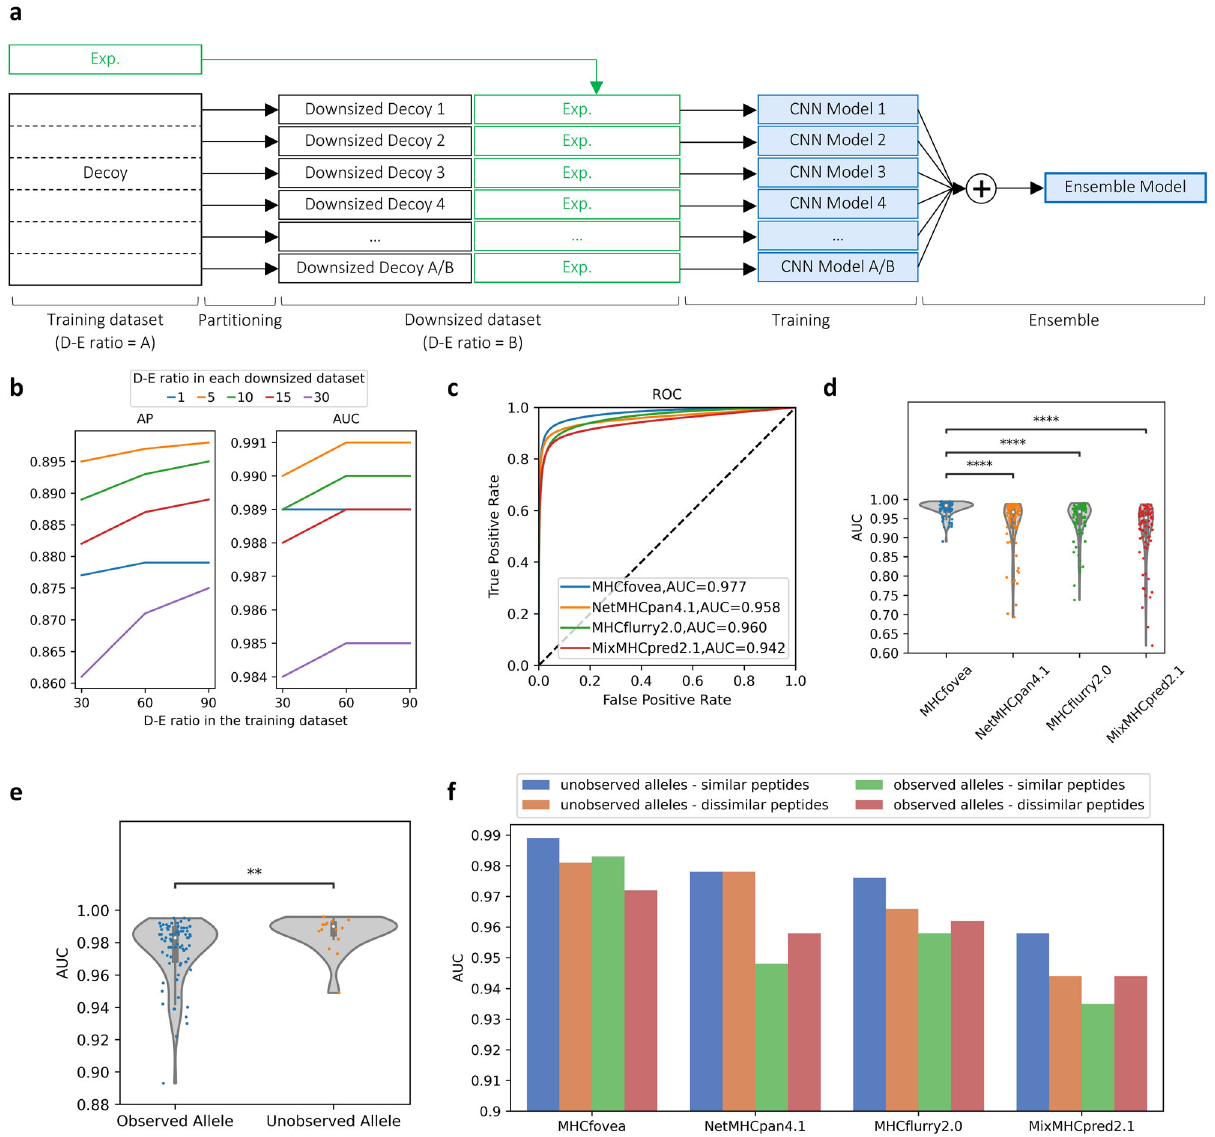
Fig. 2 The framework and performance of the MHCfovea ’ s predictor. a The ensemble framework with the partitioning strategy. We fi rst adopted the training dataset with a decoy – eluted ratio (D-E ratio) of A . The decoy dataset was partitioned into A / B downsized decoy datasets with D-E ratio of B . Then A / B CNN models were trained on one downsized decoy dataset along with the experimental dataset. Finally, the mean of results was calculated as the prediction score. b AP and AUC scores on the validation dataset of the ensemble model trained under different D-E ratios in the overall training dataset, including A = 30, 60, and 90, against different D-E ratios in the downsized decoy dataset, including B = 1, 5, 10, 15, and 30. The x -axis represents the D-E ratio in the training dataset, and the y -axis represents the metric score. Source data are provided in Supplementary Tables 2 and 3. c – f The following performances are all applied on the benchmark dataset. c The ROC curves with AUC depict the comparison between predictors. d The violin plot shows the distribution of AUC of each predictor by alleles ( n = 91, one allele was removed because it is unavailable in MixMHCpred2.1). e Comparison of the AUC between observed ( n = 76) and unobserved ( n = 16) alleles. f The comparison of AUC on the four groups split from the benchmark dataset between predictors. In violin plots, boxplots depict the median value with a white dot, the 75th and 25th percentile upper and lower hinges, respectively, and whiskers with 1.5× interquartile ranges. P values (two-tailed independent t test) are shown as ** P ≤ 0.01 and **** P ≤ 0.0001. Source data and details of the statistical analysis are provided in Supplementary Data 2, 3, and